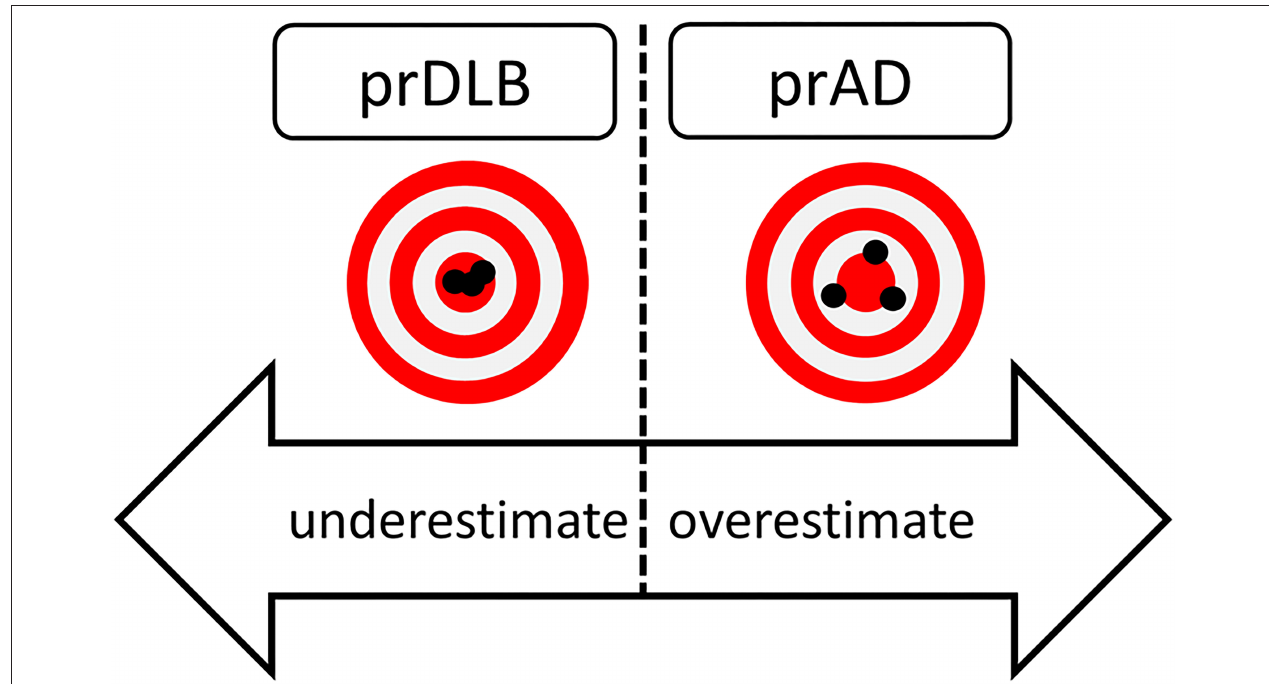
FIGURE 3 | Hypothetical figure of the results of time perception in prDLB and prAD. PrDLB tended to underestimate time while prADs were less precise and tended to overestimated time. prAD, prodromal AD dementia; prDLB, prodromal dementia with Lewy bodies.